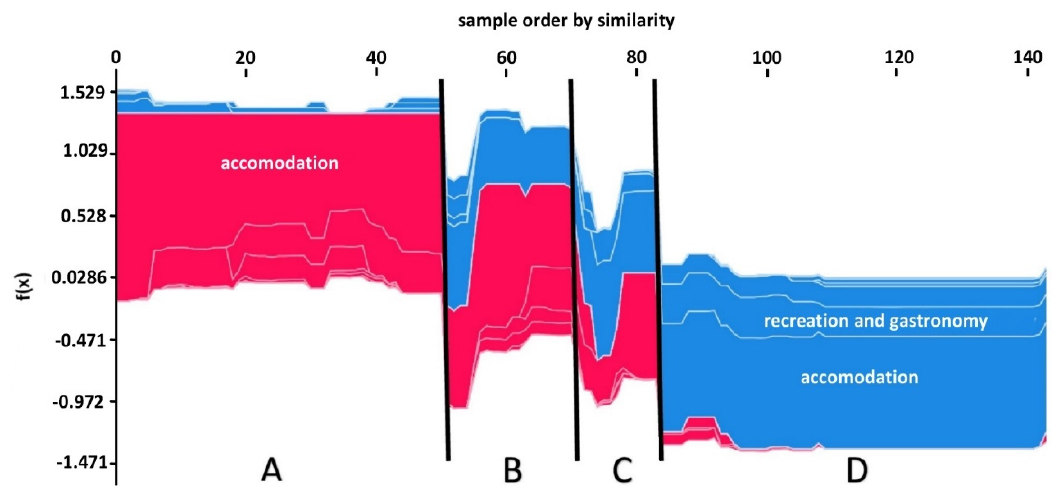
Figure 2. Assessment of the similarity of the lakes of the Olsztyn Lakeland based on the share of different LU/LC types in their surroundings on the basis of SHAP model analysis. ( A ) Shore zone with the tourism function developed; ( B ) shore zone with the recreational function developed; ( C ) shore zone with the settlement function developed; ( D ) undeveloped shore zone.